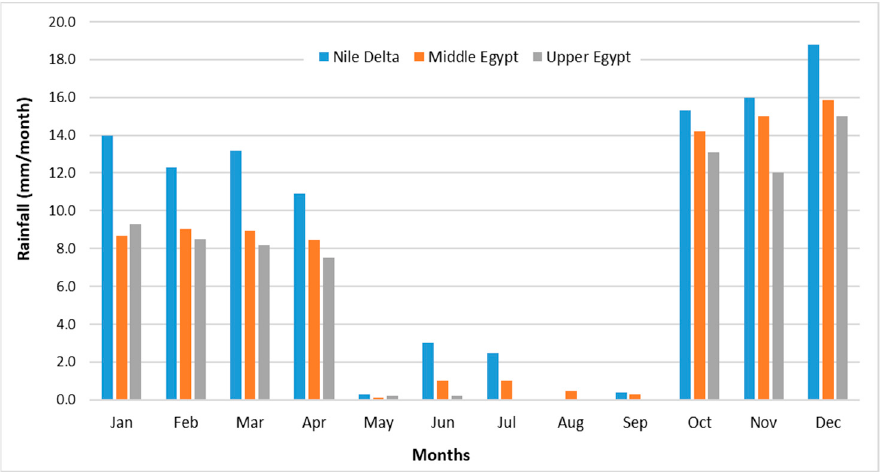
Figure 6. Mean monthly rainfall (mm) in three regions over five years from 2015 to